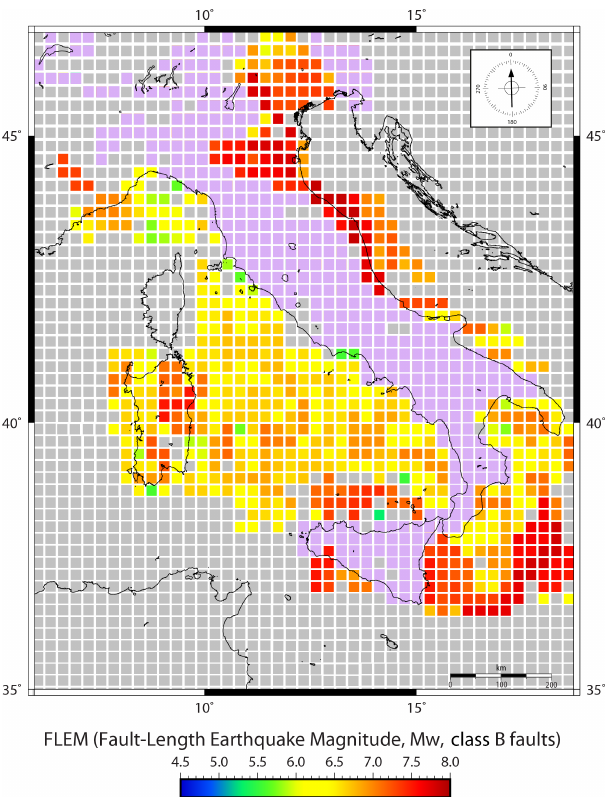
Figure 9. Map of maximum magnitude (for each cell) from historic or instrumental earthquakes as recorded in the CSI 1.1, ISIDe, and CPTI15 databases within the 1000–2017 period. Grey is for cells with no